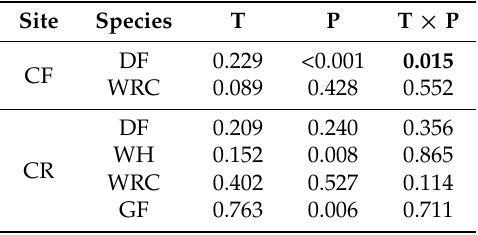
Table 2. Adjusted p -value from the time-series ANOVA for intrinsic water use efficiency (iWUE) of Douglas-fir (DF), western hemlock (WH), western redcedar (WRC), and grand fir (GF) trees growing under contrasting vegetation management treatments on sites located in the Cascade Foothills (CF) and Coast Range (CR) of western Oregon. T: effect of vegetation management treatment; P: effect of growing period; T × P: effect of interaction between treatment and growing period. Bold : result is statistically significant at p < 0.05.